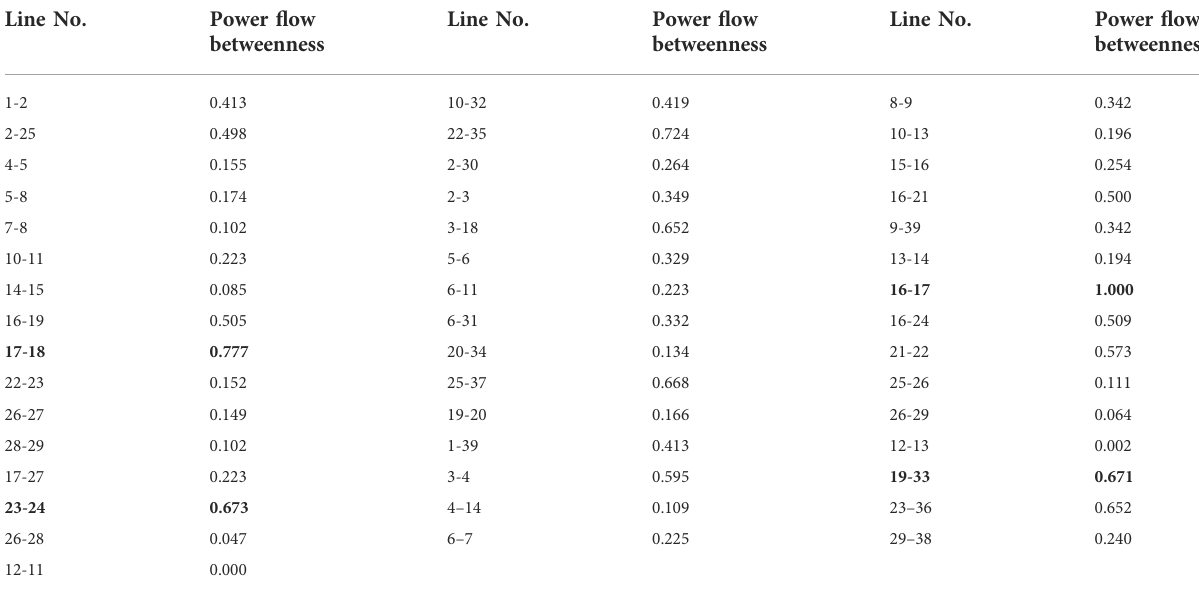
TABLE 2 Flow betweenness of lines in IEEE 39-bus system. Line No.